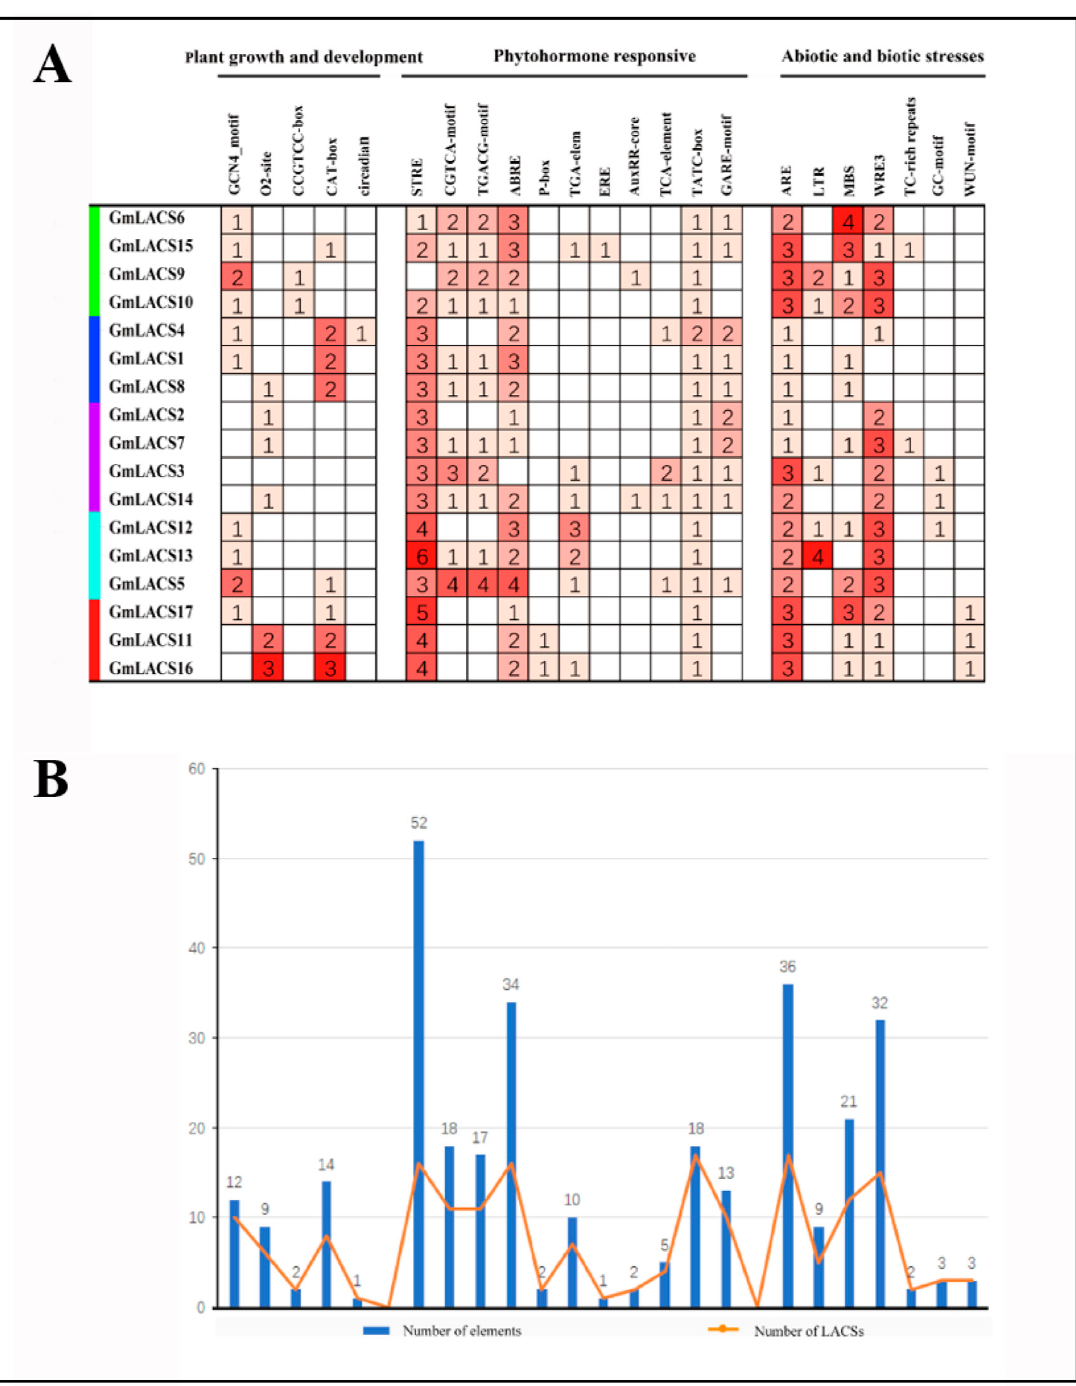
Figure 4. Cis -element analysis of 2kb promoter region upstream of GmLACSs start codon. ( A ) Number of each cis-acting element in the promoter region (2 kb upstream of the translation start site) of GmLACS genes. ( B ) Statistics for the total number of GmLACS genes, including the corresponding cis-acting element (orange) and the total number of cis-acting elements in the GmLACS gene family (blue box). On the basis of the functional annotation, the cis-acting elements were classified into three major classes: plant growth and development, phytohormone response, and abiotic and biotic stress response.